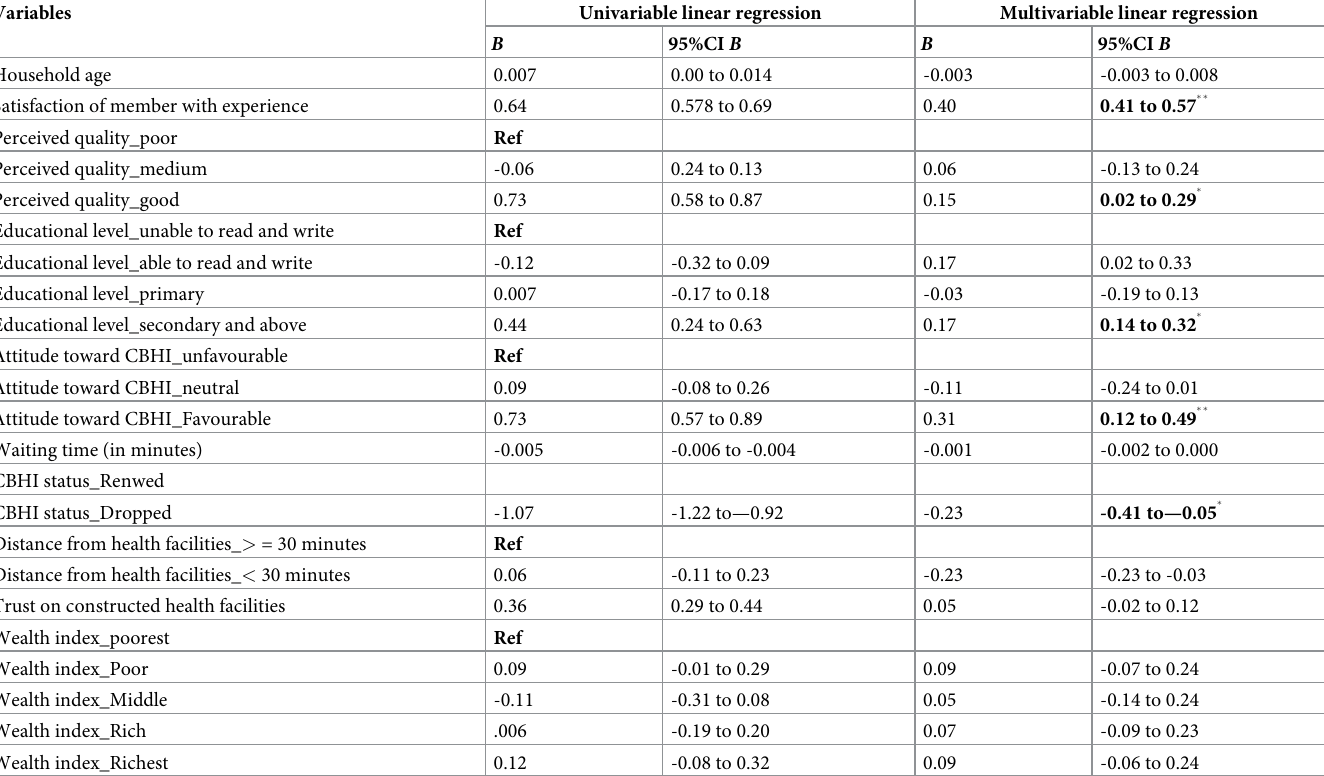
Table 3. Simple and Multivariable linear regression analysis for determinants of trust of member in CBHI scheme among households of Manna district, Jimma zone, southwest, Ethiopia,